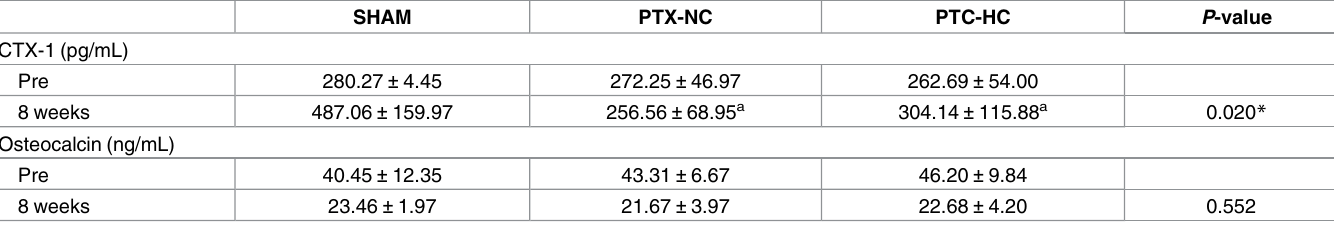
Table 4. Bone turnover markers. Data are expressed as the means ± standard deviation.